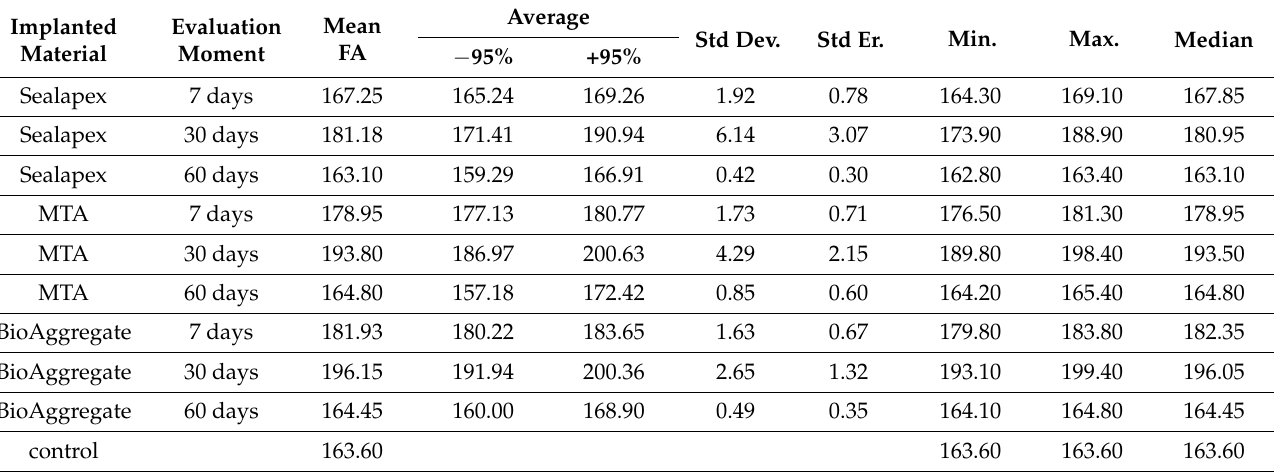
Table 4. Statistical indicators of alkaline phosphatase in the study group according to the biomaterial used and time of